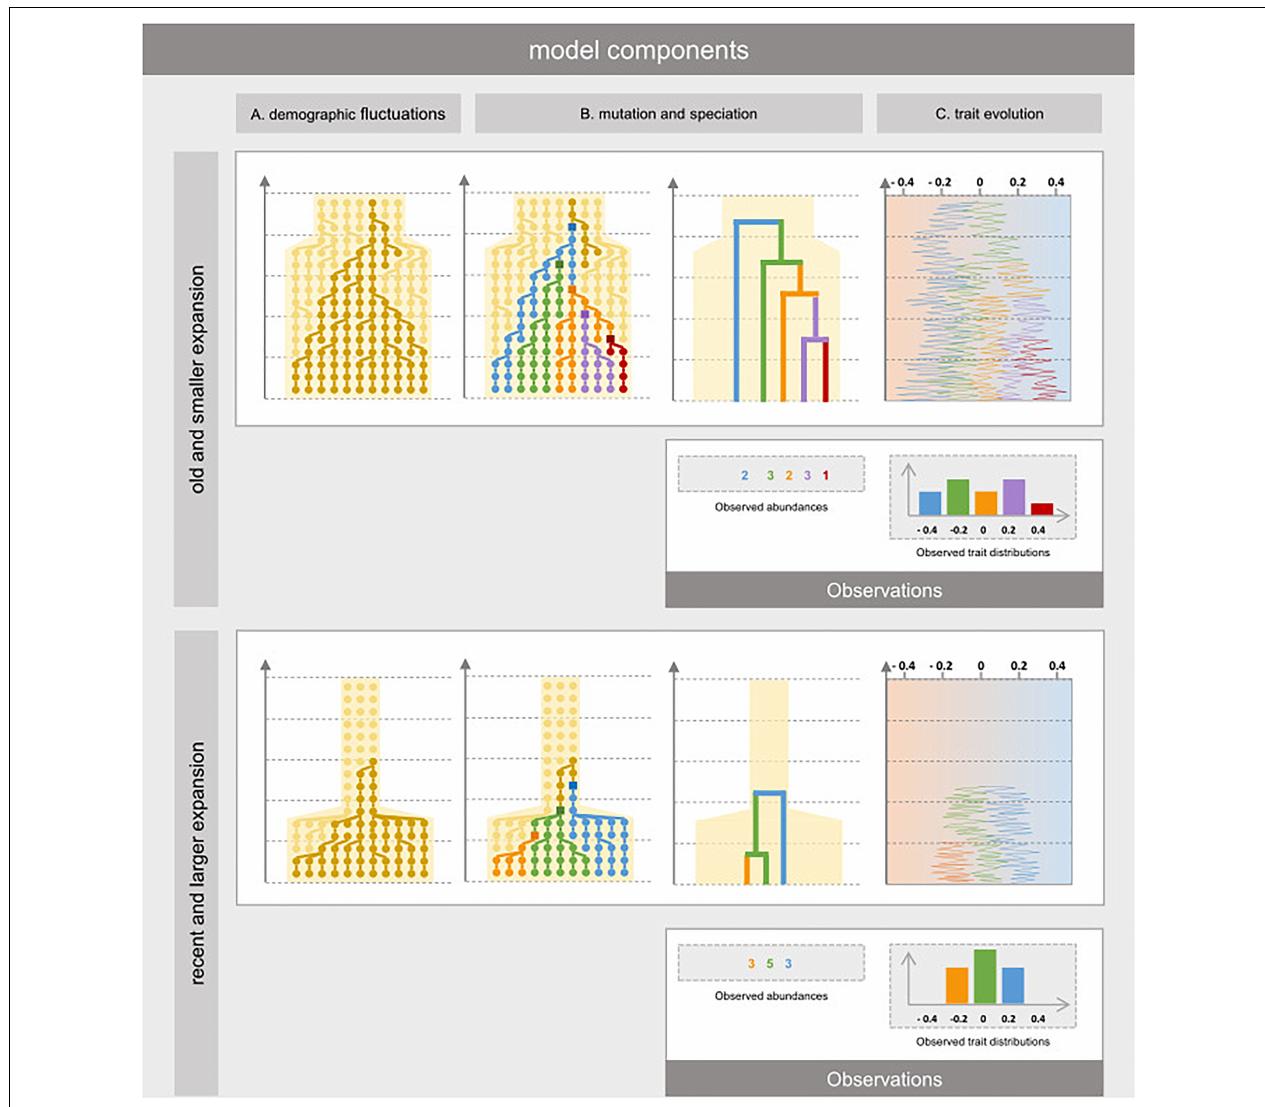
FIGURE 2 | Eco-evolutionary dynamics of individual organisms in a habitat that experienced reduction in the past. The model relies on three components. (A) The population component reconstructs the effect of habitat expansion on the past co-ancestry in the genealogy of extant individuals, using coalescent theory without assuming to which species they belong to. (B) The evolutionary component represents how divergent genotypes have made new species over time. It is modeled by first sprinkling mutation events over the simulated genealogy conditionally its branch lengths. Then, the phylogenetic relationships amongst individuals and their abundances are obtained by merging paraphyletic clades into single species depending on the topology of the genealogy. (C) The trait evolution component is modeled using Brownian motion (BM), Early Burst (EB) of Late Burst (LB) along the simulated phylogeny and represents how species niches may have changed over time and at which pace. We represent two extreme scenarios: small demographic expansion (relative to refugia) that occurred long ago (top) and important habitat expansion that occurred recently (bottom) and how these have led to different patterns of taxonomic, phylogenetic, and functional